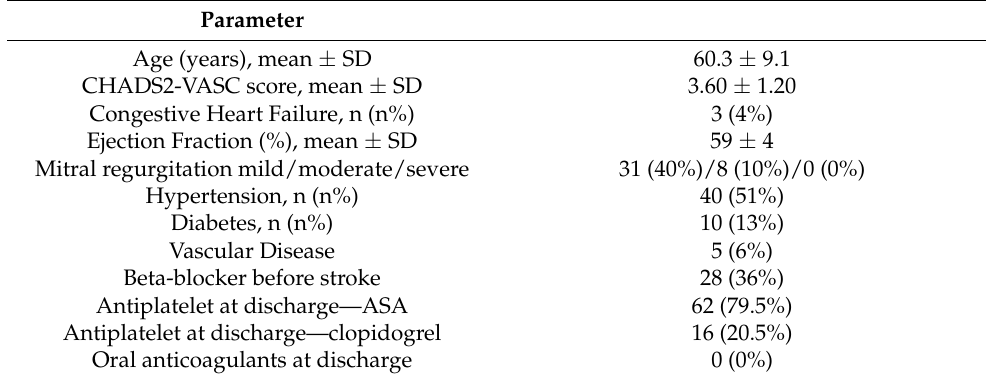
Table 1. Baseline characteristics of the studied group.